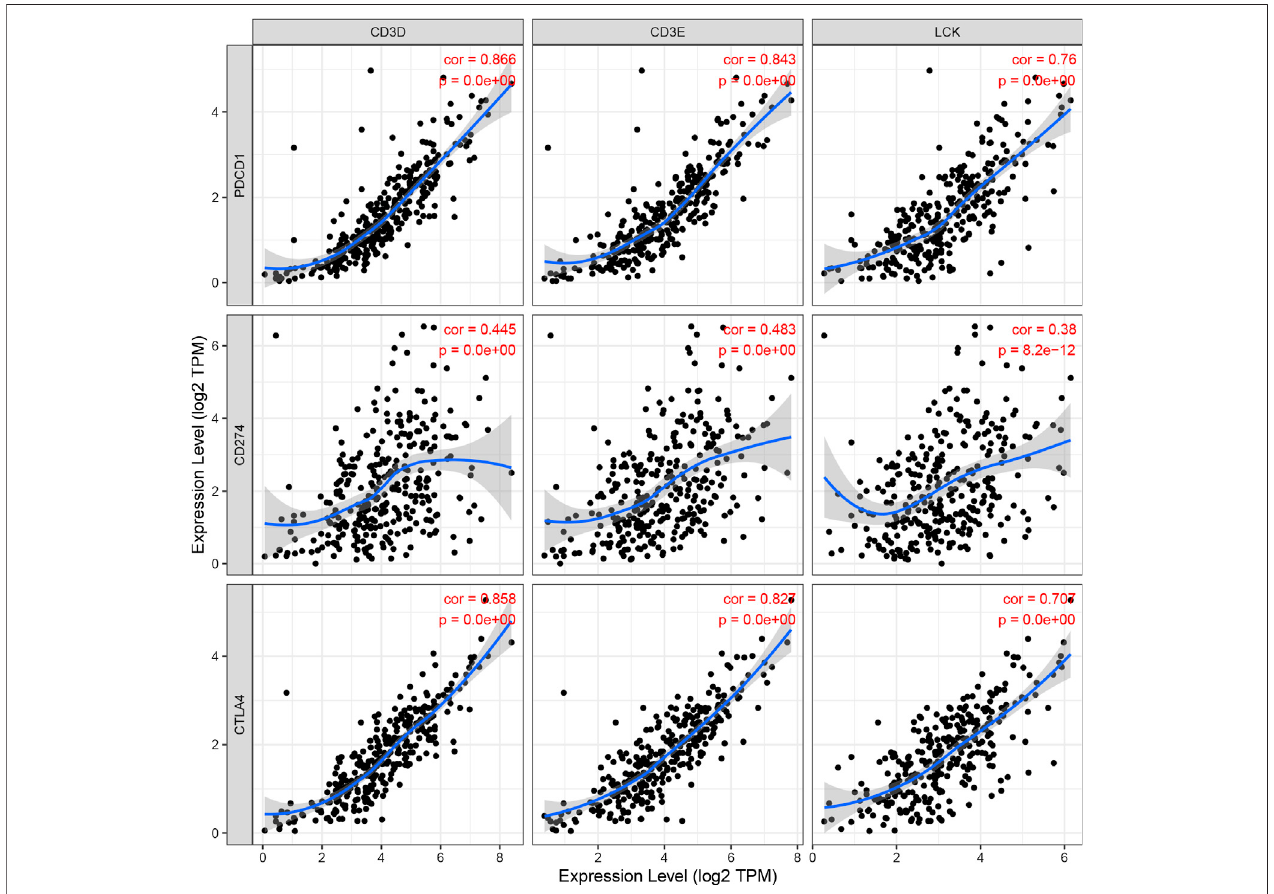
FIGURE 10 | The correlation of CD3D, CD3E, LCK expression with immune checked molecular, including PDCD1(PD1), CD274(PD-L1), and CTLA4.